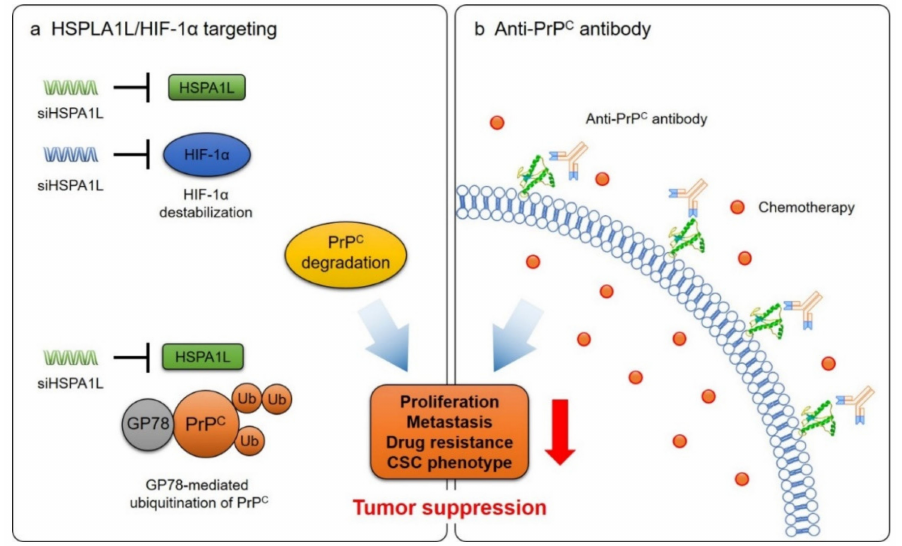
Figure 2. Strategies to suppress the tumor progression by regulating the expression and function of PrP C . ( a ) In tumor niche, the expression of HSPA1L is increased. HSPA1L binds and stabilizes HIF-1 α . HSPA1L directly binds to GP78 and inhibits its ubiquitination activity. Overall, PrP C expression is increased in tumor cells. Therefore, knocking down HSPA1L and HIF-1 α expression induces degradation of PrP C and tumor suppression. ( b ) Direct targeting of PrP C using anti-PrP C antibodies